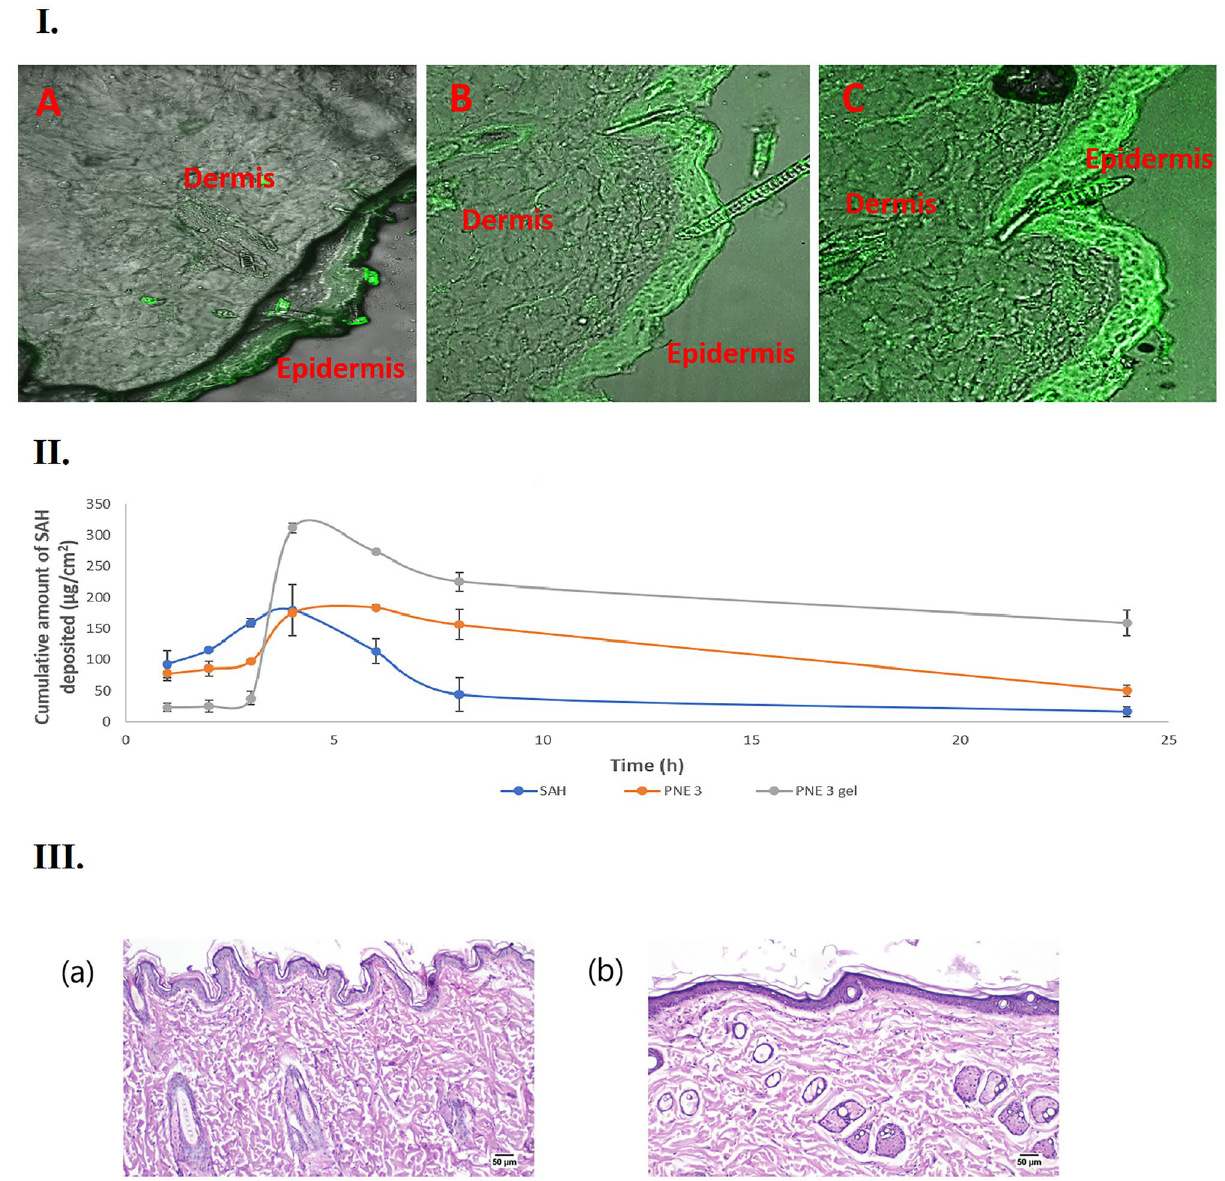
Figure 4. ( I ) Confocal laser scanning micrographs (CLSMs), obtained after 8 h following the application of Rhodamine B dye aqueous solution ( A ), Rhodamine B dye-loaded PNE 3 ( B ), and Rhodamine B dye-loaded PNE 3 gel ( C ), ( II ) The plot of the amount of SAH deposited per unit area in rat skin after the application of SAH, PNE 3, and PNE 3 gel, and ( III ) Histopathological photomicrographs of skin tolerance study; showing histopathological sections (hematoxylin- and eosin-stained) of ( a ) Untreated rat’s skin (group A); showing a normal histological structure of the epidermis and the skin appendages, and ( b ) Rat’s skin treated with SAH- loaded PNE 3 gel (group B) showing an apparent normal architecture of the epidermis and the dermis at 50